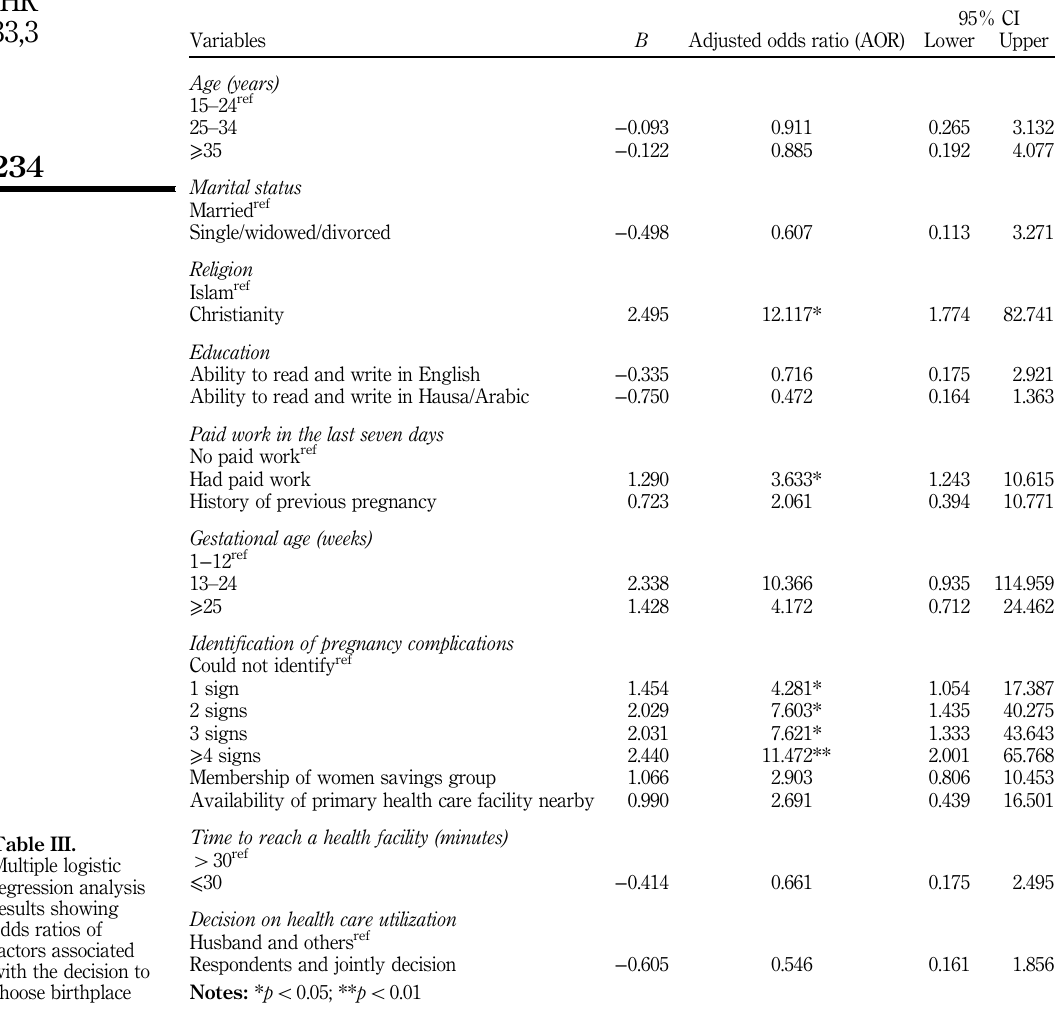
Table III. Multiple logistic regression analysis results showing odds ratios of factors